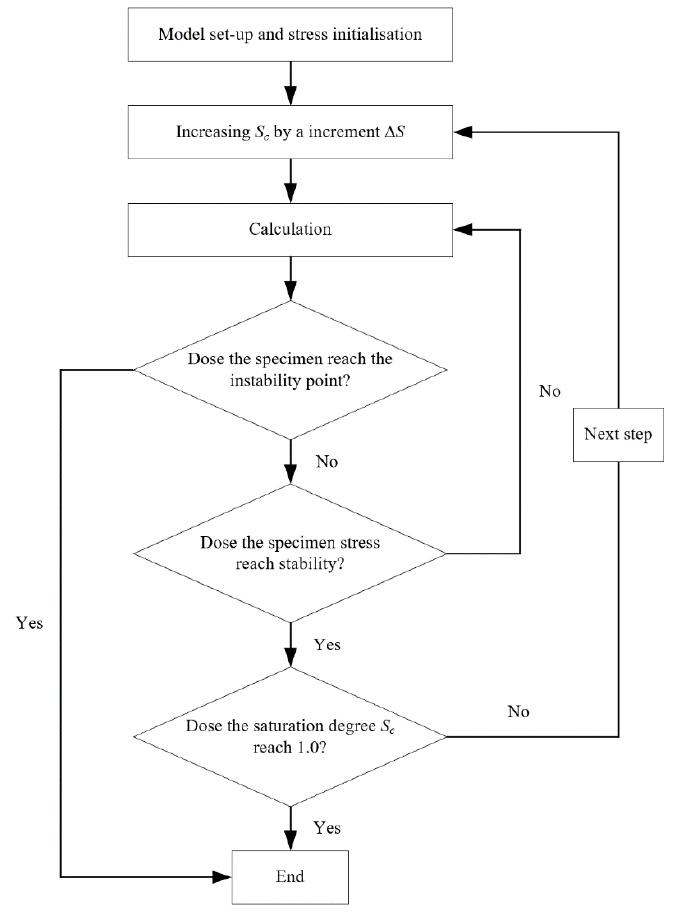
Figure 5. Flow chart for the simulation procedure.